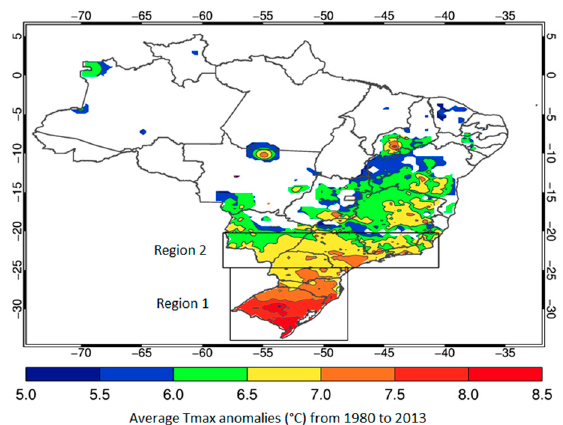
Figure 1. Composition of daily maximum temperature anomalies in Brazil, based on Heat Wave Duration Index (HWDI), from 1980 to 2013.